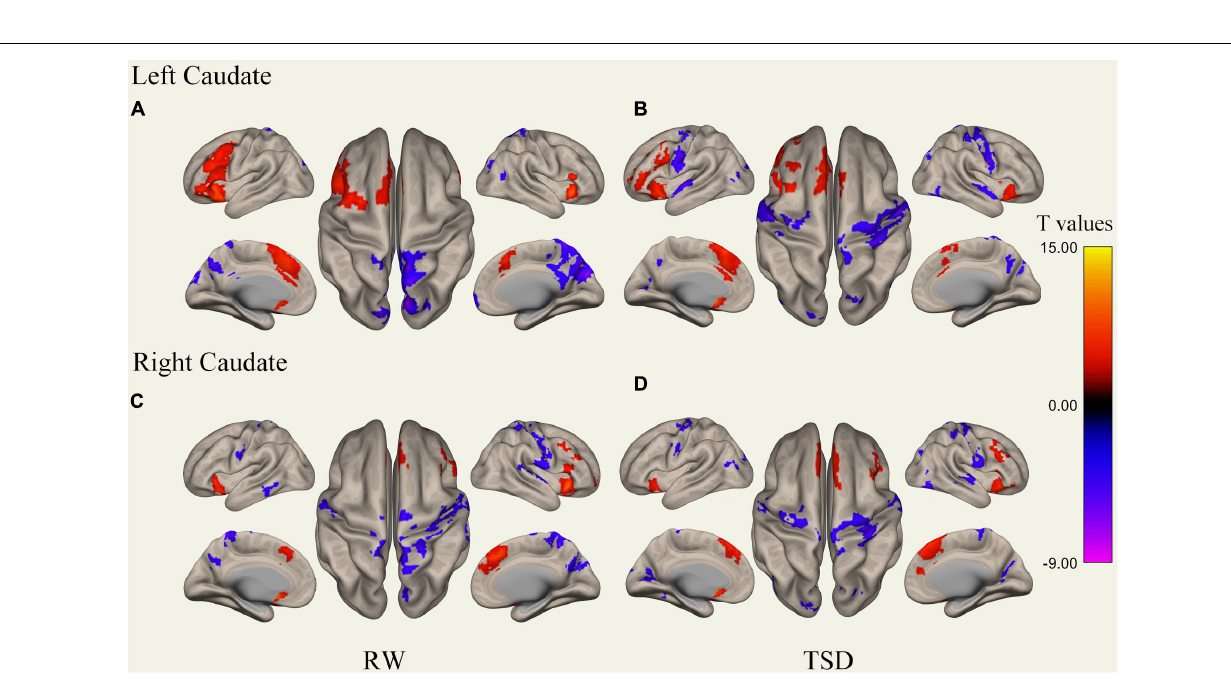
Frontiers in Neuroscience |